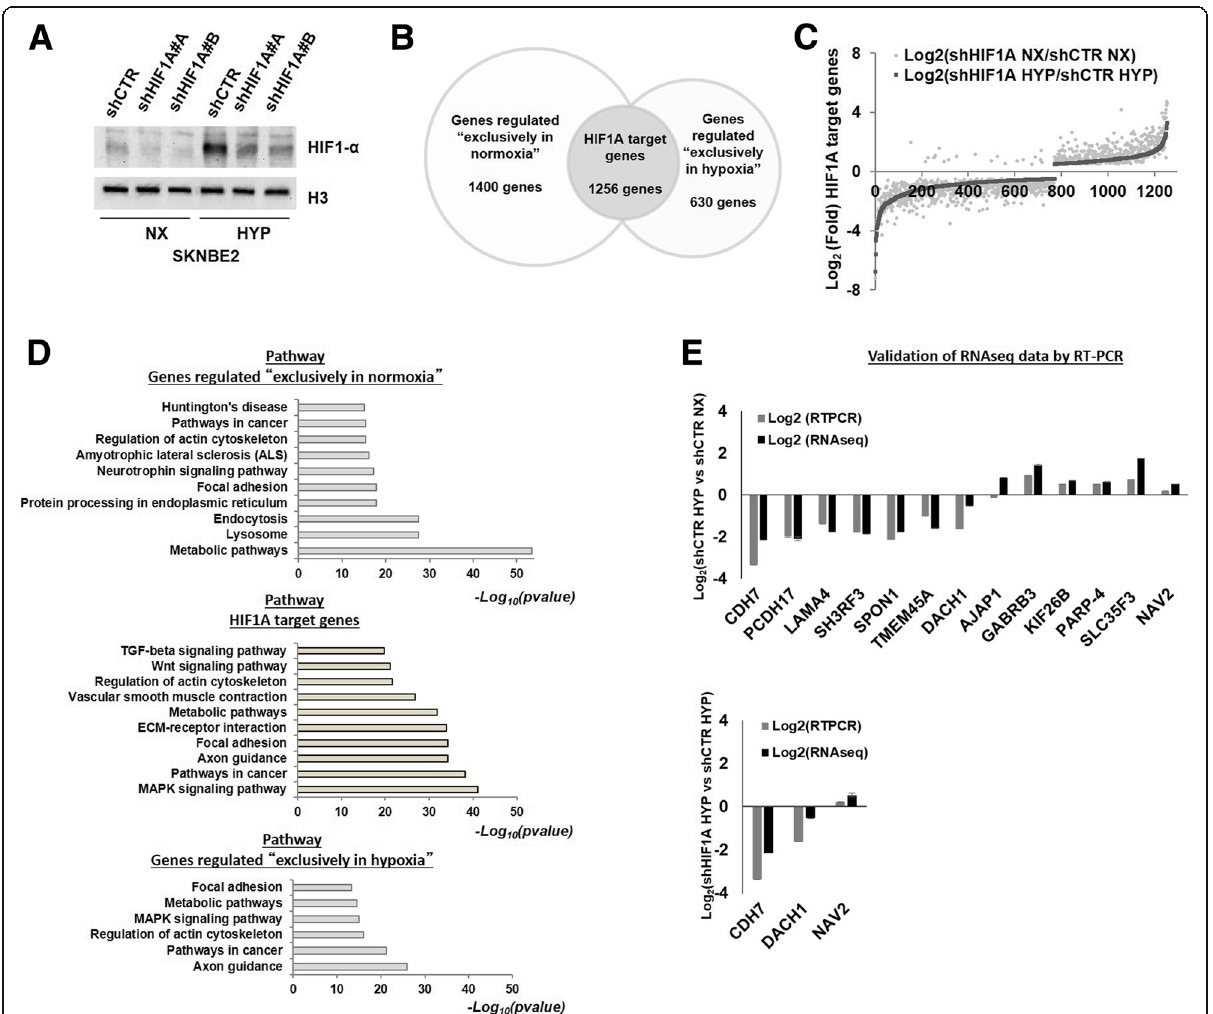
Fig. 1 HIF1A driven response in normoxia and in hypoxia conditions. a HIF1A depletion in SKNBE2 was verified by western blotting. The silencing was madiated by two short hairpin against HIF1A (shHIF1A#A and shHIF1A#B). Unsilenced cells were used as control (shCTR). SKNBE2 shHIF1#B was used for RNA sequencing experiments. b The differentially expressed genes in shHIF1A NX vs shCTR NX and in shHIF1A HYP vs shCTR HYP gene sets were crossed and three gene lists were obtained: genes regulated “ exclusively in normoxia ” , genes regulated “ exclusively in hypoxia ” and HIF1A target genes. The number of genes for each gene list is reported in the graph. c The Log2 expression of HIF1A target genes is reported for each gene set. d KEGG pathway analysis (webGestalt) of the three gene lists is shown. The negative Log 10 pvalue is reported on X- axis (FDR ≤ 0.05). e The reliability of RNAseq data was estimated by assessing the expression values of chosen genes by RT-PCR in SKNBE2 shHIF1A#A and shCTR cells. Log 2 Fold of expression in RT-PCR and RNAseq experiments is